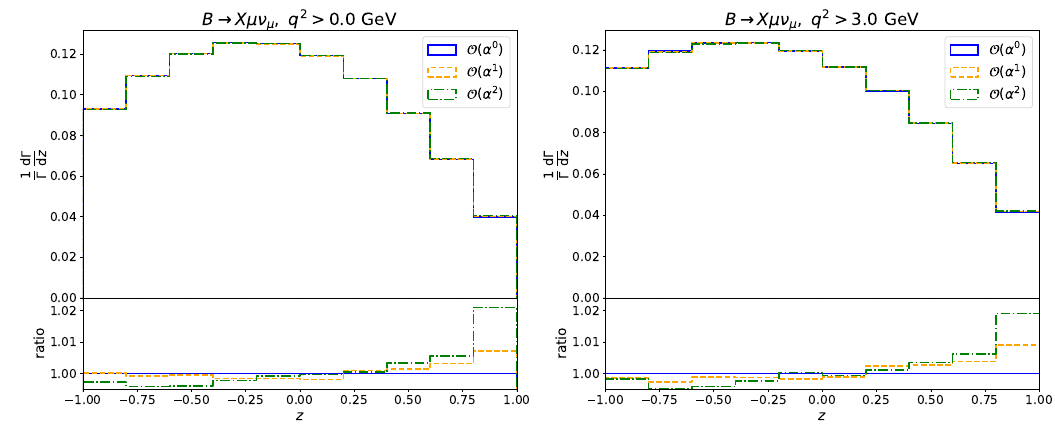
Figure 6: The differential decay rate for B → X µν µ decays. The left-hand figure is without a cut on q 2 , while the right-hand figure includes a lower cut on q 2 of 3 GeV 2 . ( α 0 ) , ( α 1 ) and ( α 2 ) denote no final-state radiation, soft final-state The labels O O O radiation only and a full YFS treatment,